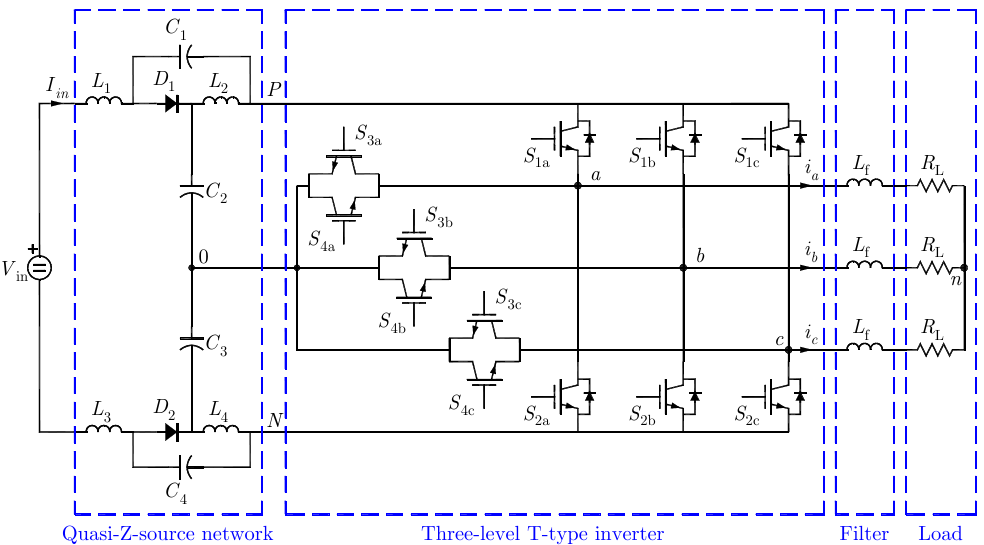
Figure 1. Schematic of the three level (3L) T-type, quasi-Z-source inverter.